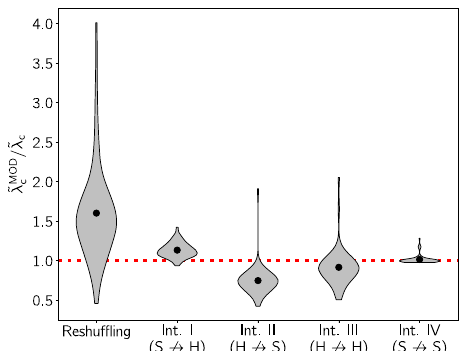
Fig. 4 Impact of mobility interventions on the epidemic threshold for cities in the United States. The impact is quanti fi ed with violin plots representing the distribution for the ratio between the normalized threshold after each intervention, ~ λ MOD and the normalized threshold of the original c mobility network ~ λ c. The dots inside each violin plot shows the mean of each distribution whereas the red dotted line shows the expected value of this ratio in absence of intervention. Here, S and H refer to suburbs and hotspots respectively, and S ↛ H represents the restriction of fl ow from suburbs to hotspots while keeping all other fl ows the